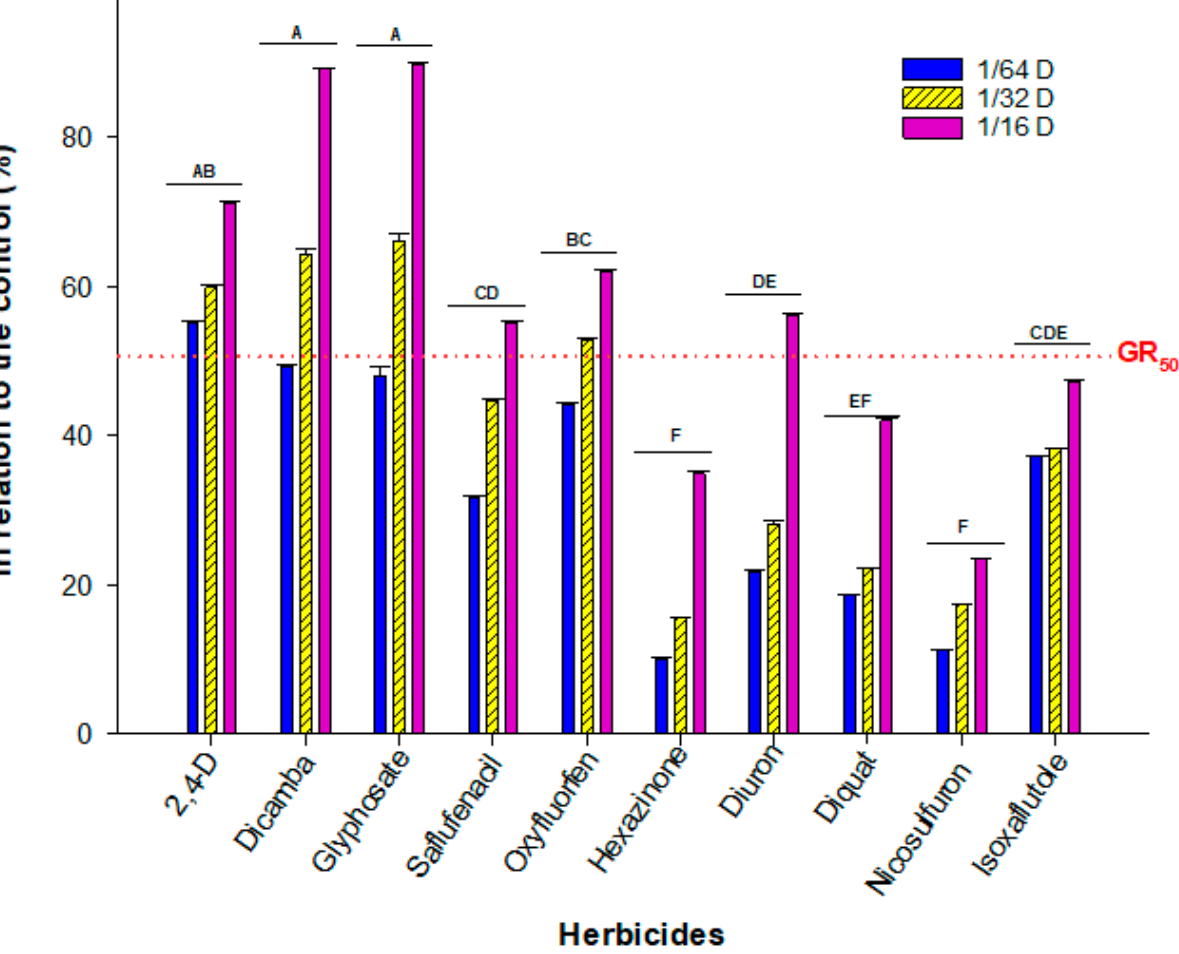
Figure 21. Dry mass (DM) reduction (%) at 21 days after application (DAA) in relation to the control treatment, under di ff erent herbicide subdoses in the simulated drift of 2,4-D (146.56, 73.28, and 36.64 g a.e. ha − 1 ), dicamba (45, 22.5, and 11.25 g a.e. ha − 1 ), glyphosate (138.75, 69.38, and 34.69 g a.e. ha − 1 ), sa fl ufenacil (8.75, 4.38, and 2.19 g a.i. ha − 1 ), oxy fl uorfen (90, 45, and 22.5 g a.i. ha − 1 ), hexazinone (24.75, 12.38, and 6.19 g a.i. ha − 1 ), diuron (200, 100, and 50 g a.i. ha − 1 ), diquat (43.75, 21.88, and 10.94 g a.i. ha − 1 ), nicosulfuron (3.75, 1.88, and 0. 94 g a.i. ha − 1 ) and isoxa fl utole (16.41, 8.20, and 4.10 g a.i. ha − 1 ). The subdoses correspond to the proportion of 1/16D, 1/32D, and 1/64D of the commercial dose, respectively. The simulated drift doses with equal capital le tt ers do not di ff er from each other by Tukey’s test ( p < 0.05). The GR 50 represents the dose that causes a 50% DM reduction. There was an interaction observed between the level of tomato injury and glyphosate dose ratios, wherein there was a progressive increase in injury levels as the applied doses